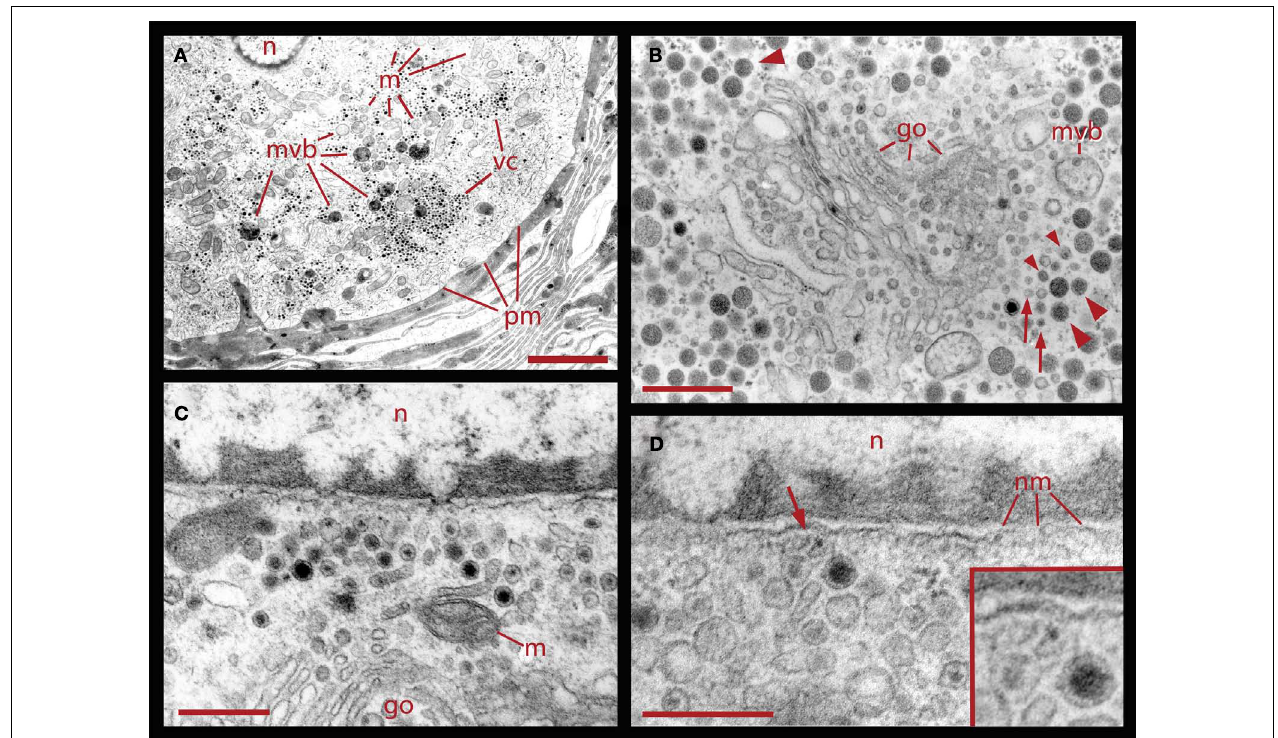
electron dense material (small arrowheads). More distantly there are small vesicles with dense cores continued by vesicles with large dense cores (large arrowheads). A fragment of a multivesicular body (mvb) can also be seen. On the top left electron dense vesicles align with the layers of the Golgi apparatus (large arrowhead). (C) Higher magnification image of vesicles adjacent to the nucleus, in the vicinity of mitochondria (m) and Golgi. (D) Clear and dense core vesicles are adjacent to the nuclear membrane (nm). A filament projecting from the vesicle toward the nuclear membrane is marked by the arrow and amplified in the inset. Scale bars for (B–D) =